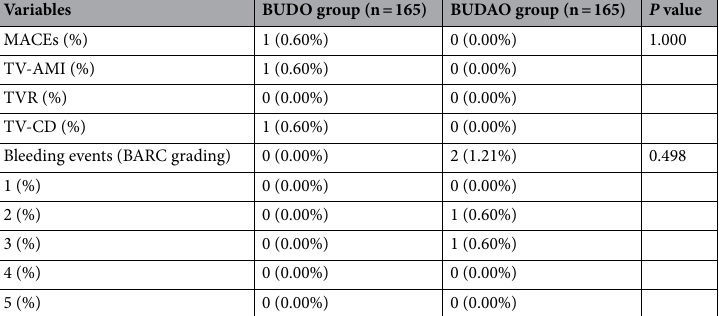
Table 4. In-hospital MACEs and bleeding events in the BUDO and BUDAO groups. Data were expressed as n (%). MACEs Major adverse cardiac events; TV-AMI Target vessel-acute myocardial infarction; TVR Target vessel revasculization; TV-CD Target vessel-cardiac death; BARC Bleeding academic research consortium.